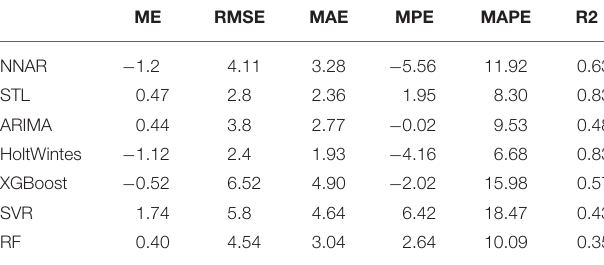
TABLE 2 | Accuracy index of testing